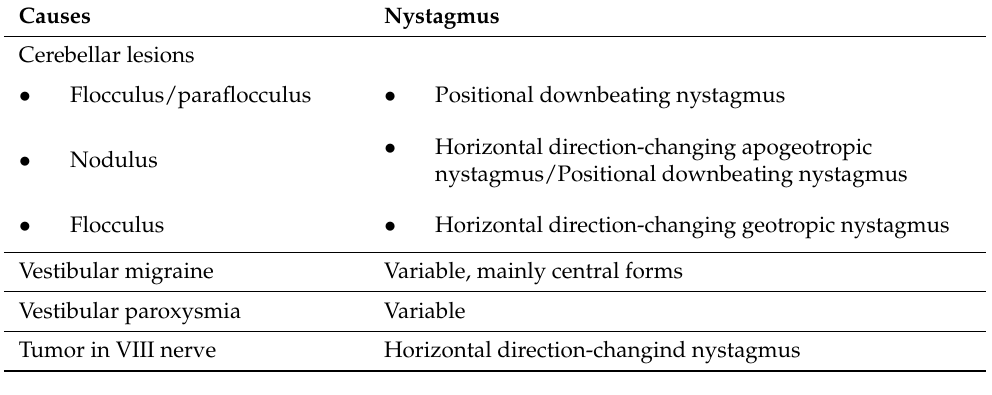
Table 2. Definitive APV causes.